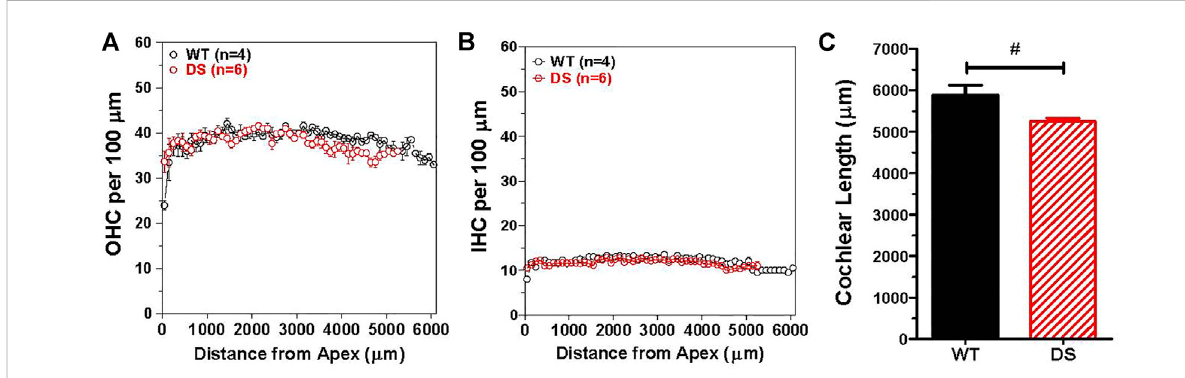
FIGURE 7 OHCandIHCdensitiesinDSmicearesimilartoWTmice,butlengthofcochleaissigni fi cantlylongerinWTmicethanDSmice.Mean(+/ − SEM) numbers of (A) OHCs and (B) IHCsin100 μ m intervals as afunctionof distance from theapex ofthecochleainDS( n = 6) andWT ( n =4) mice. Mean OHCandIHCdensities(haircells/ μ m)inDSmicearesimilartothoseinWTmiceovertheapical5,250 μ